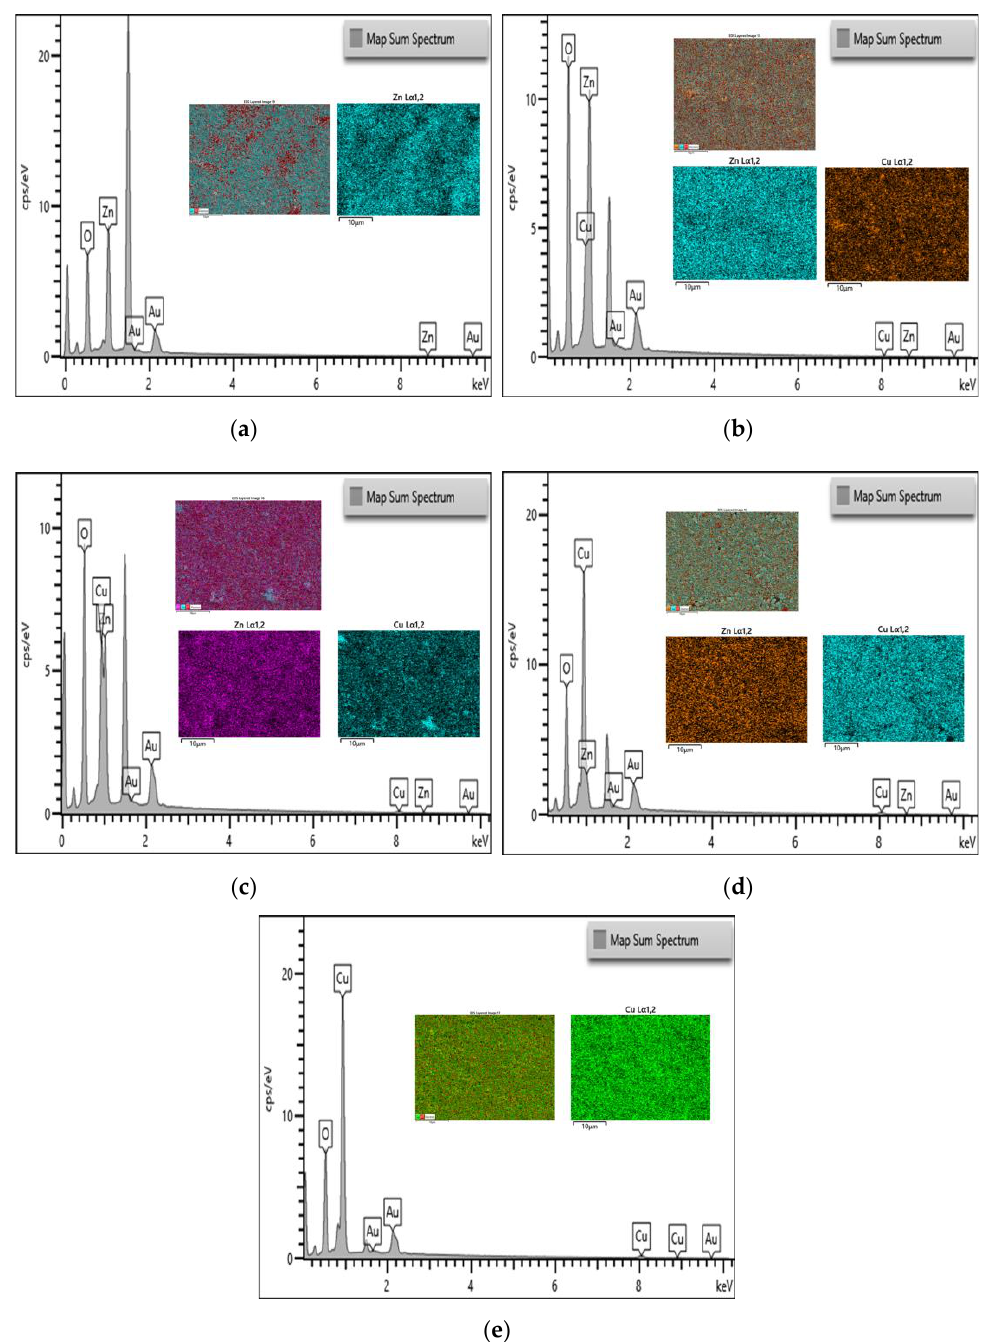
Figure 4. EDX quantitative spectra chart results of ZnO-CuO/water hybrid nanofluid with pattern mapping of the element distribution mixed at ratio of ( a ) 10:0, ( b ) 7:3, ( c ) 5:5, ( d ) 3:7, ( e ) 0:10 .